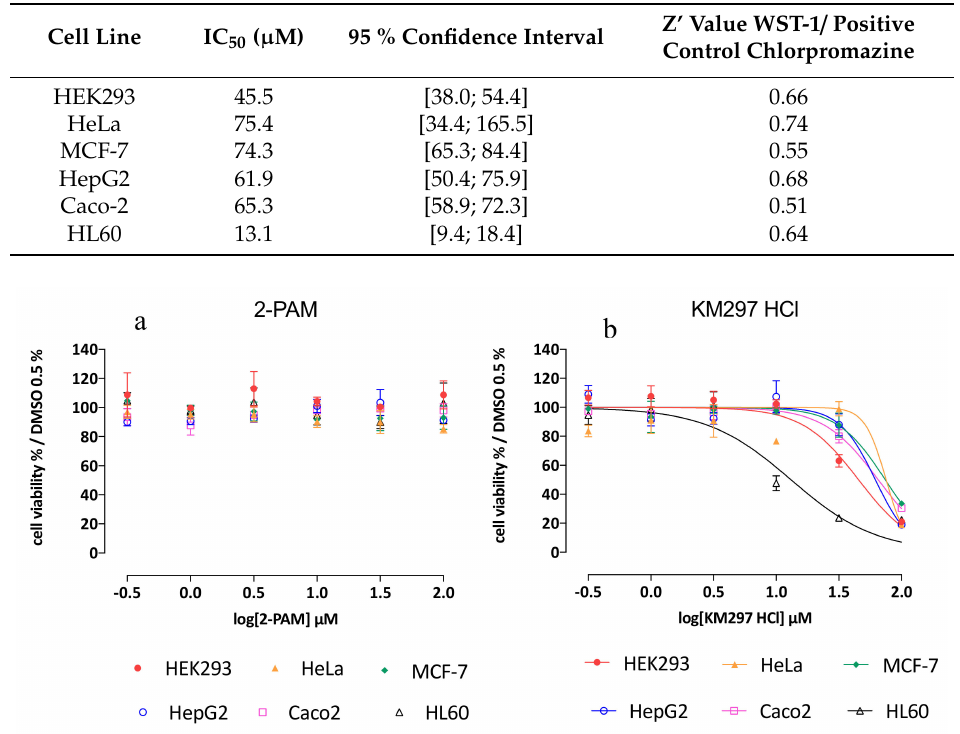
Table 4. IC 50 values of cell viability WST-1 assay, their respective 95% confidence interval and calculated Z’ value following KM297 HCl exposure of each cell line.